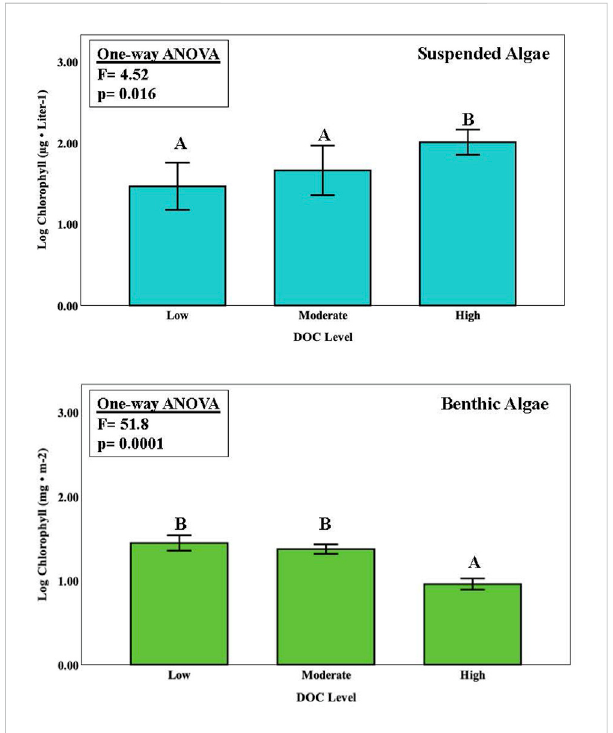
FIGURE 2 Chlorophyll concentrations (average ± one standard error) for suspended and benthic algal assemblages among three sites in the Chippewa River watershed where 3 × 3 factorial experiments were performed for varying levels of N and P enrichment (9 nutrient treatments). Common lettering joins treatments where no signi fi cant differenceswere observed (TukeyHSD pairwise comparisons, p < 0.05). One-way ANOVA was run separately (blocked) for the site treatment.